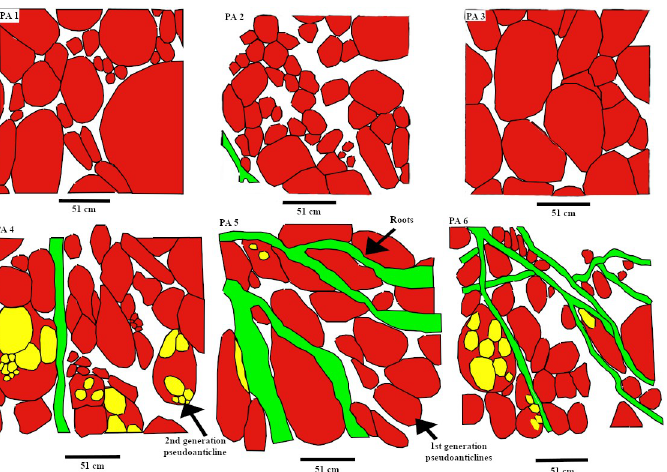
Fig 5. The variation in the sizes of the pseudoanticlines in rooted and unrooted areas. Roots trace fossils are shown in green color, the first generation pseudoanticlines in red, and the second generation in yellow colors. PA 1–3 is the maps of the pseudoanticlines in the unrooted areas along section C-D. The PA-4 is the map of the pseudoanticlines in the proximal area of the lycopsid root system. PA-5 is the map of the pseudoanticlines in the proximal area, and PA-6 in the distal area of